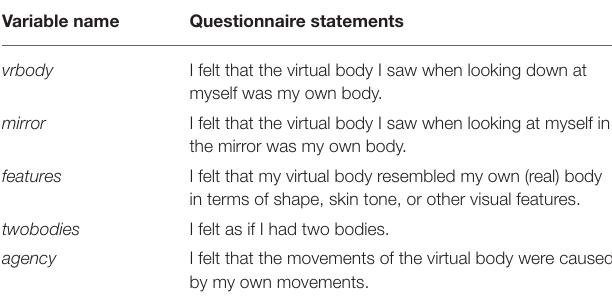
TABLE 2 | Questionnaire items.